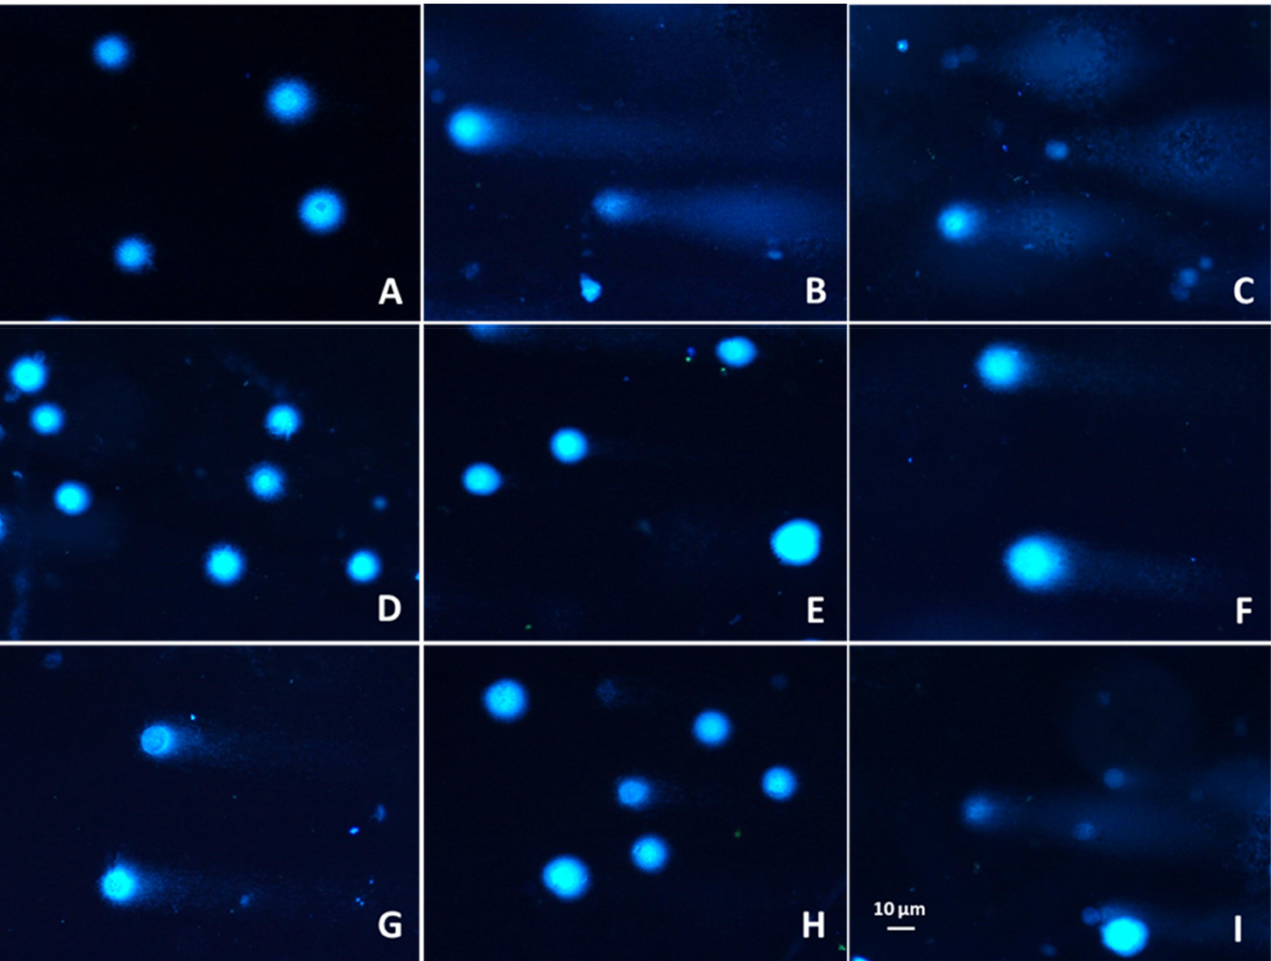
Figure 4. Representative photos of Caco-2 comets after staining with 1 mg/mL DAPI, where the head is composed of intact DNA and the tail consists of damaged DNA (single-strand or double-strand breaks): ( A )-negative control (cells treated with the vehicle); ( B )-cells treated with H 2 O 2 (25 µ M); ( C )-cells treated with MNNG (6.8 µ M). Comets visualized after 120 min cells post-treatment with H 2 O 2 and AGE ( D ), pAGE ( E ), BJE2 ( F ), pBJE2 ( G ). Comets visualized after 120 min cells post-treatment with MNNG and BJE1 ( H ), pBJE1 ( I ). Apium graveolens extract, AGE; Brassica juncea extract, BJE, purified extracts (p). Fluorescence microscopy (Nikon, Tokyo, Japan); objective 20 ×